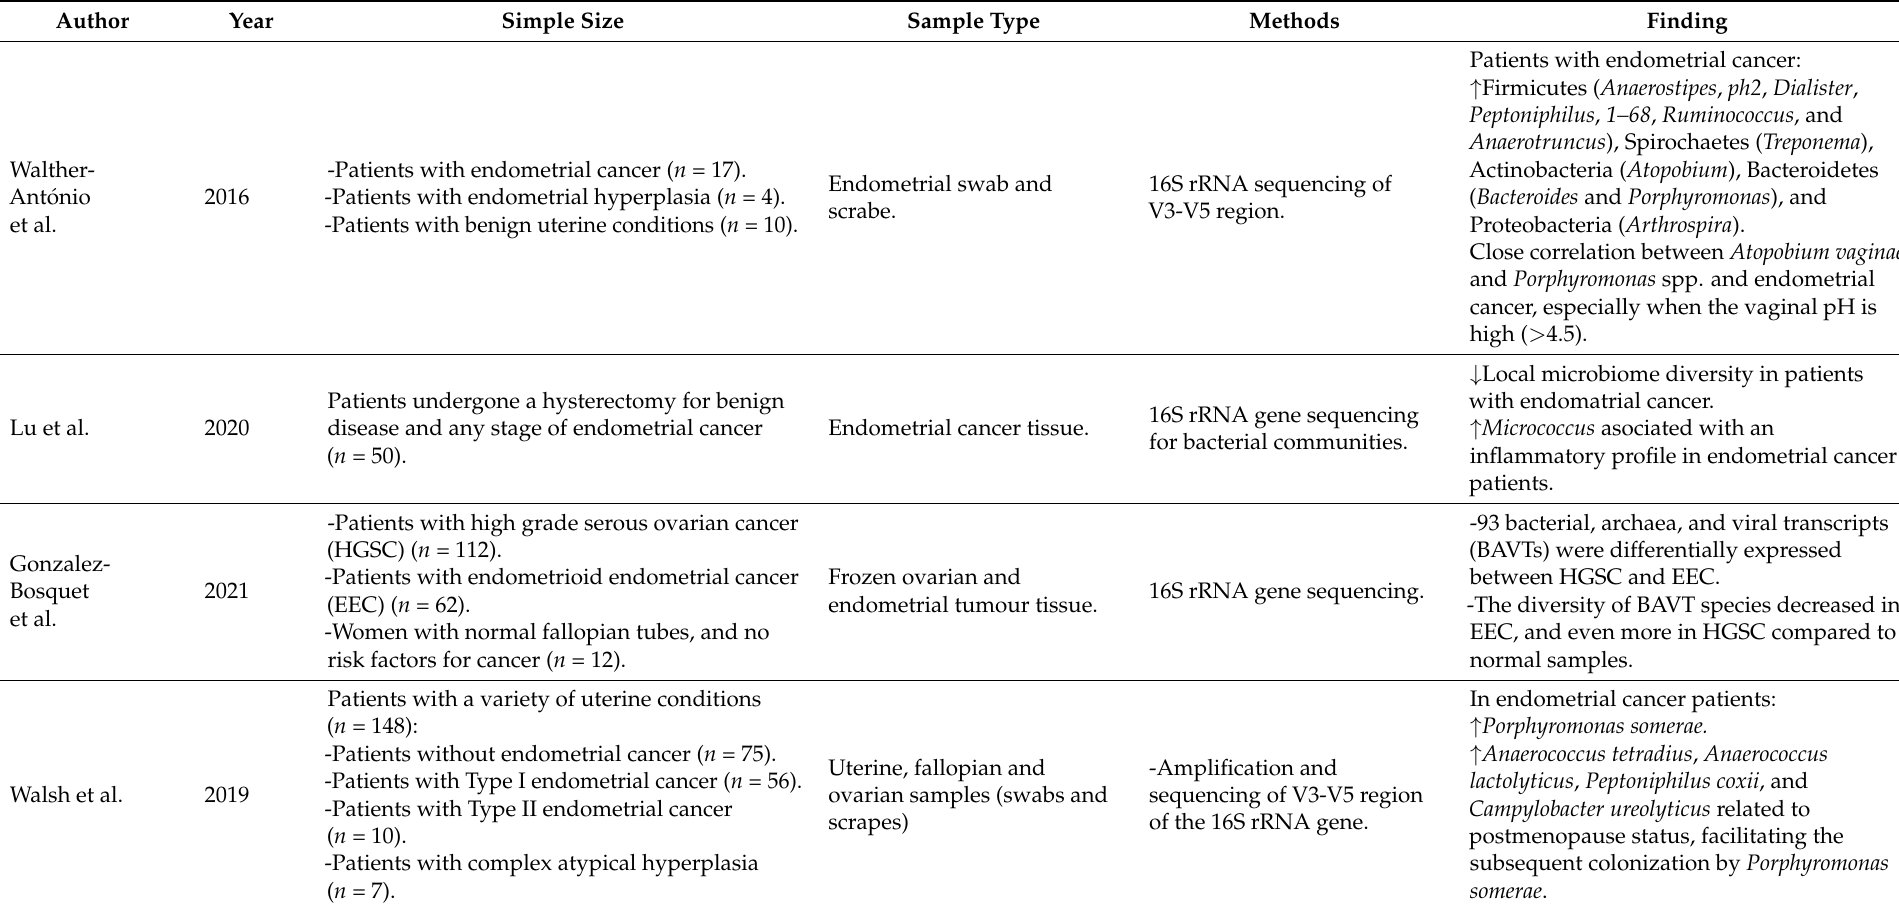
Table 2. Studies of intratumoural microbiota in endometrial cancer